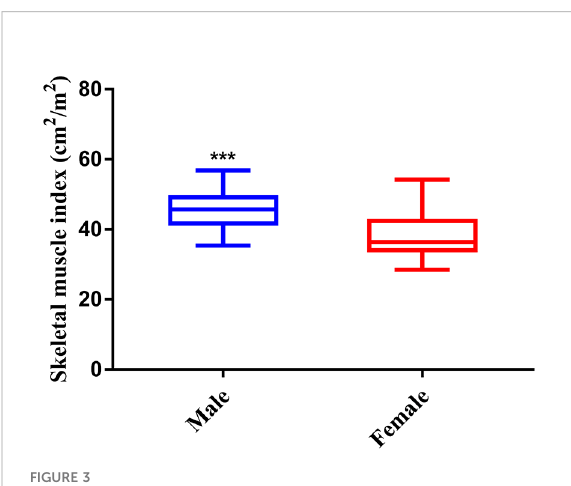
FIGURE 3 Skeletal muscle index between male and female patients. *** P <